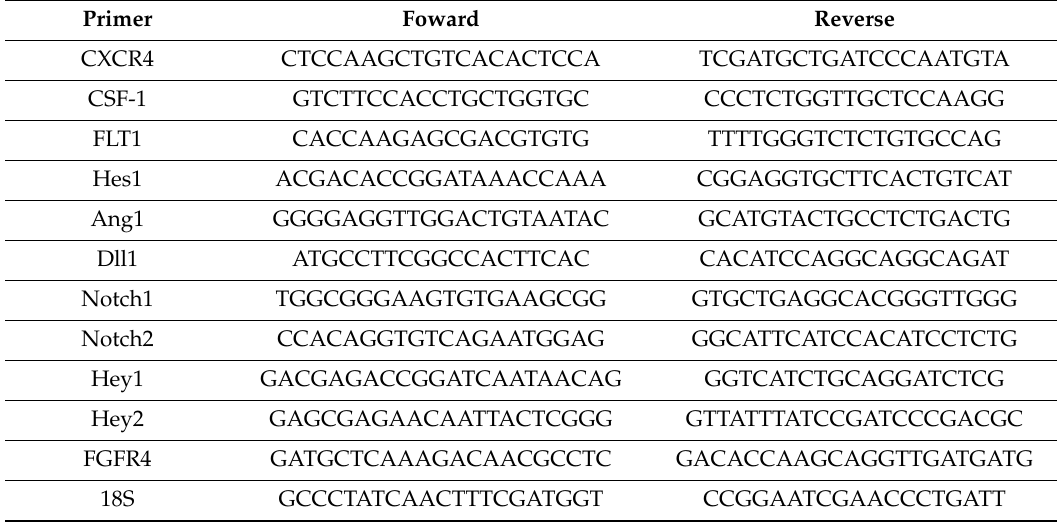
Table 1. List of primers used for